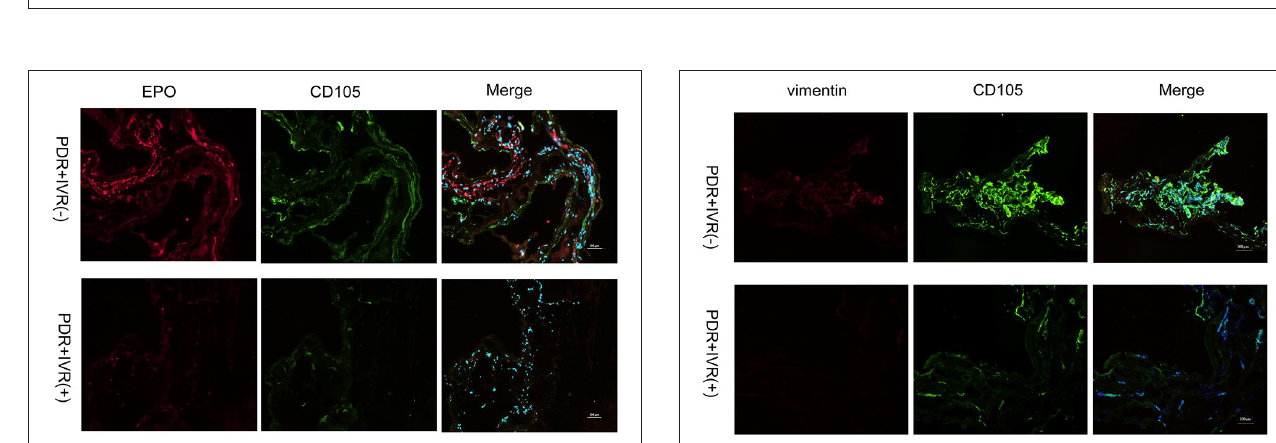
FIGURE 2 | (A) Shows a scatter plot for the correlation between log-transformed vitreous VEGF and EPO levels in patients with PDR. (B) Receiver operating characteristic (ROC) curve of EPO and VEGF levels in PDR.